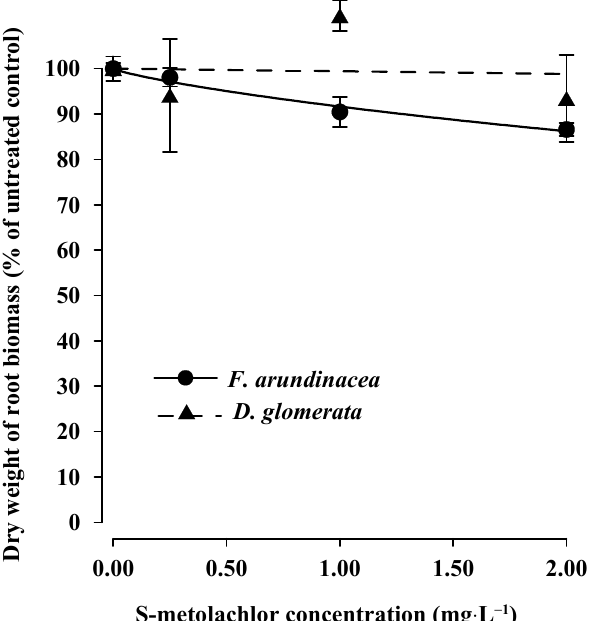
Figure 3. E ff ects of S-metolachlor (SMR) concentrations on dry weight root biomass of F. arundinacea (tall fescue) and D. glomerata (orchardgrass) at 87 DAT. The symbols indicate the observed data, the lines show the fitted curves according to a logistic dose–response model. Vertical bars represent ± standard error.